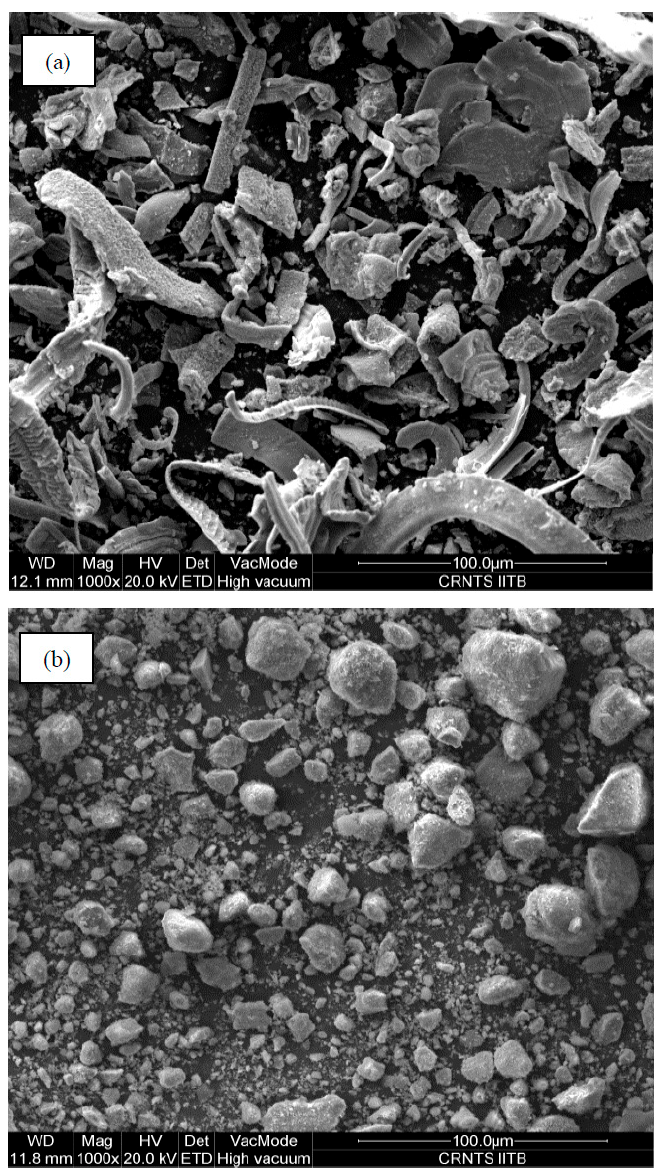
Figure 1. Scanning electron micrographs of ( a ) grinding-sludge powder and ( b ) iron-ore